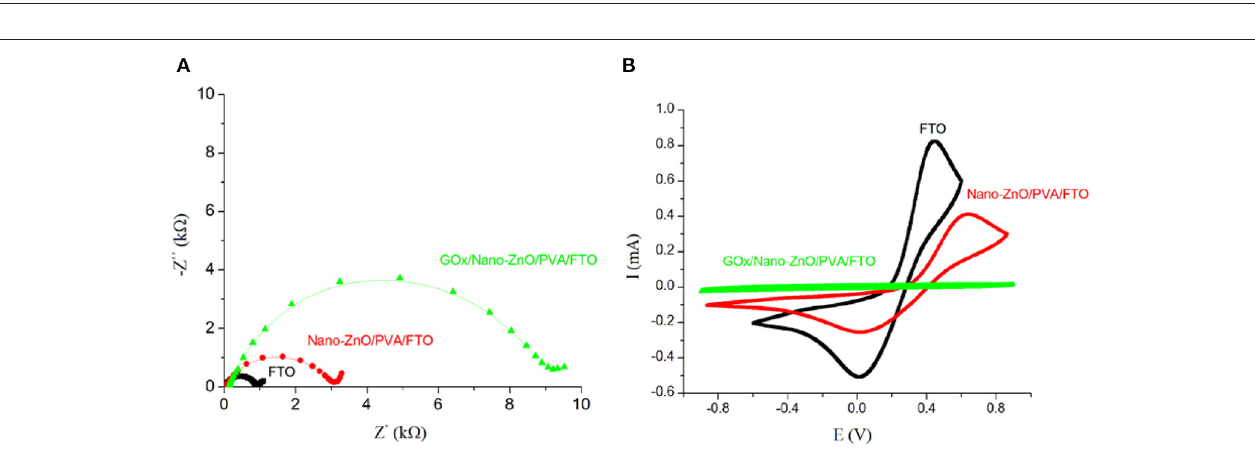
FIGURE 5 | (A) Nyquist plots of a solution containing 5mM [Fe(CN) 6 ] 3 − / 4 − at the surface of fluorinated tin oxide (FTO), nano-ZnO/polyvinyl alcohol (PVA)/FTO, and glucose oxidase (GOx)/nano-ZnO/PVA/FTO. (B) Cyclic voltammograms (scan rate of 0.1V s − 1 ) of a solution containing 5mM [Fe(CN) 6 ] 3 − / 4 − at the surface of